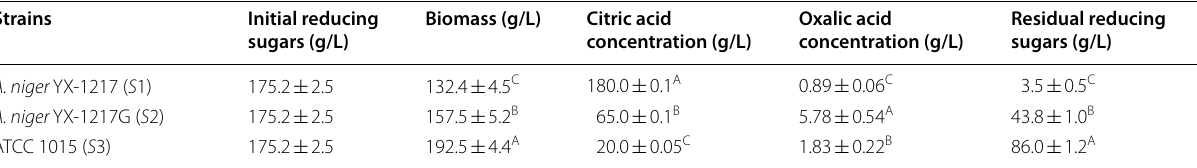
Fermentations were performed in biological triplicate for each strain. Values are presented as the average was listed as a level, and different uppercase letters represent extremely significant differences ( p < 0.01)